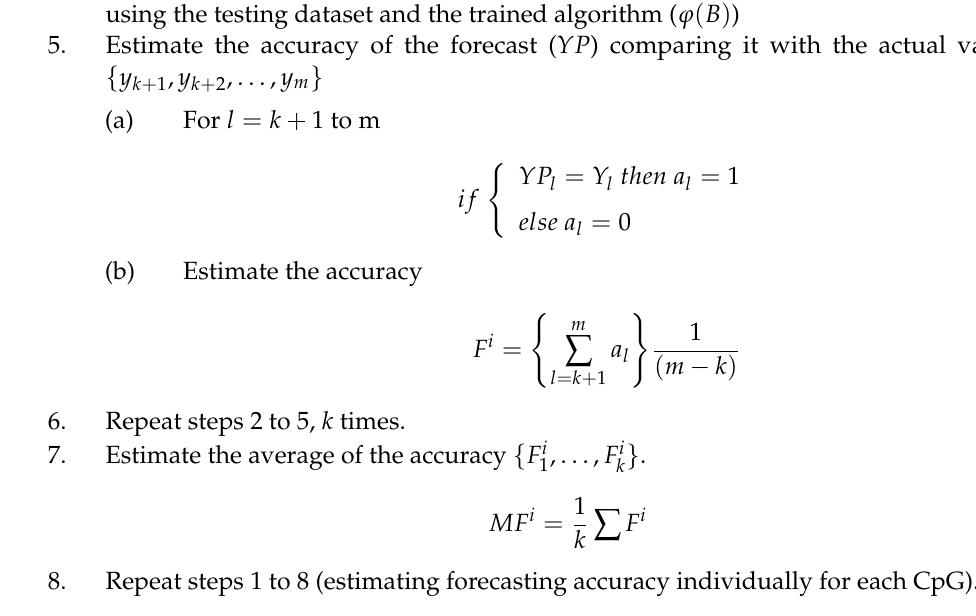
Repeat steps 1 to 8 (estimating forecasting accuracy individually for each CpG).